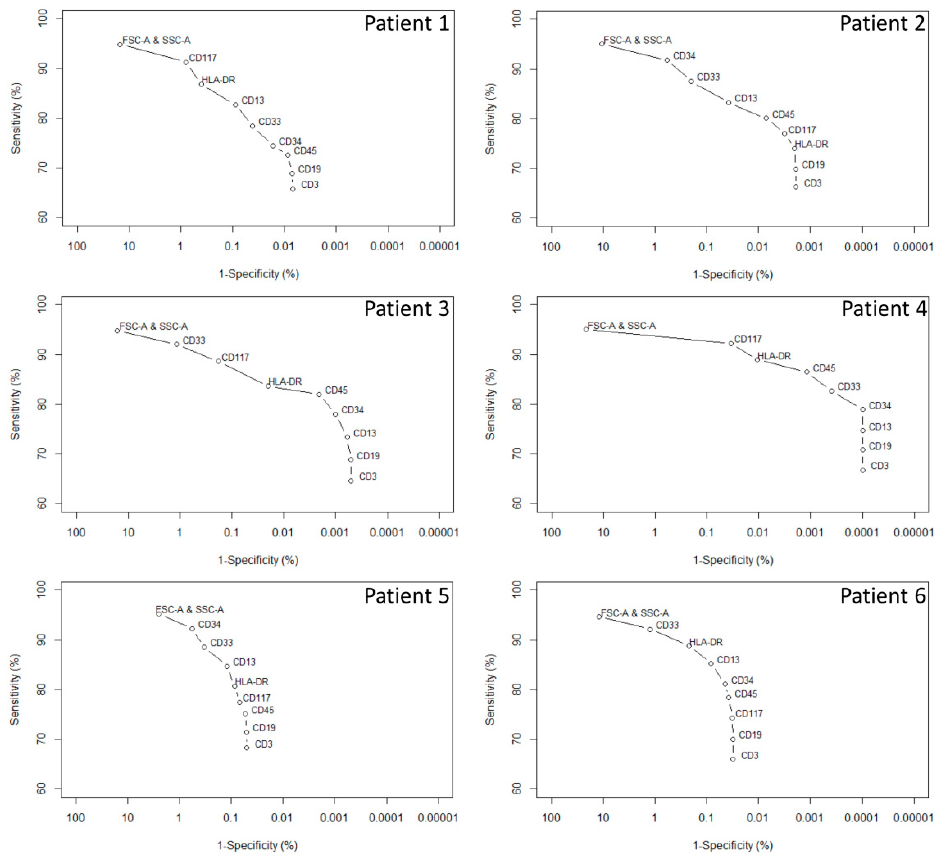
Figure 3. Influence of the parameters on the sensitivity and specificity of each patient-specific L-Cloud. The abscissa (1-specificty %) indicates the false positive rate of the L-Cloud (%); the ordinate indicates the L-Cloud sensitivity (%). Using Infinicyt software and patient-specific L-Clouds, established on the basis of 10 4 cells from the major malignant cell cluster of six AML patients at diagnosis (patients 1–6), a forward selection based on the L-Cloud specificity (using a mixture 1 × 10 6 of normal cells from reference samples) was performed for each patient (1–6). In a first step, the FSC-A and SSC-A parameters were selected. In the following steps, the other parameters were introduced one at a time. At each step, the improvement in specificity was determined for each remaining parameter and the one with the highest improvement was added. The process was repeated until all parameters were introduced. The L-Cloud represents a model describing a multidimensional space where malignant cells are found. This region is patient-specific and is established following a well-defined algorithm at diagnosis (see Section 2.2). The L-Cloud sensitivity is defined by the number of cells from the “L-Cloud cell cluster” falling into the L-Cloud divided by the number of cells contained into this same cluster ( = 10 4 cells) as a percentage. The L-Cloud specificity is defined by the number of cells of the control group falling outside the L-Cloud divided by the number of cells of the control group analyzed ( = 10 6 cells) as a percentage.